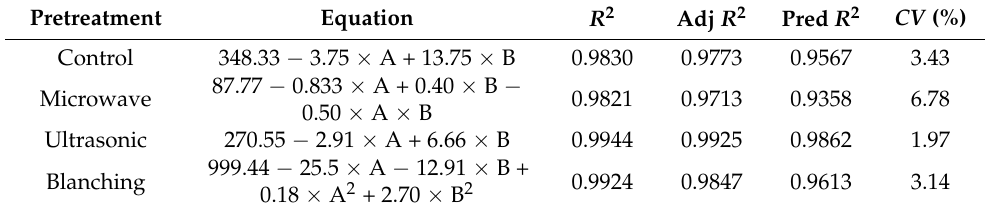
Table 2. Response surface method (RSM) modeling results for predicting the drying time under a hybrid convective-infrared (HCIR) dryer with various pretreatments.